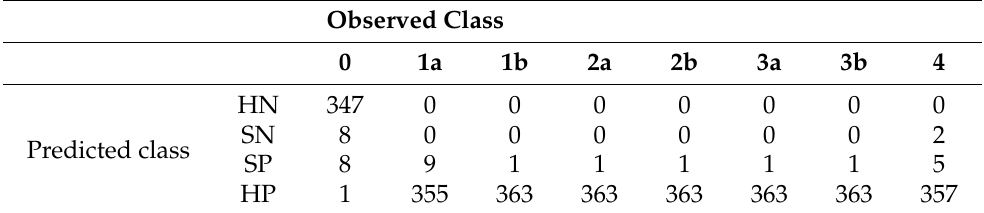
Table 14. Confusion matrix for the validation set and the SVM model. Multi-class